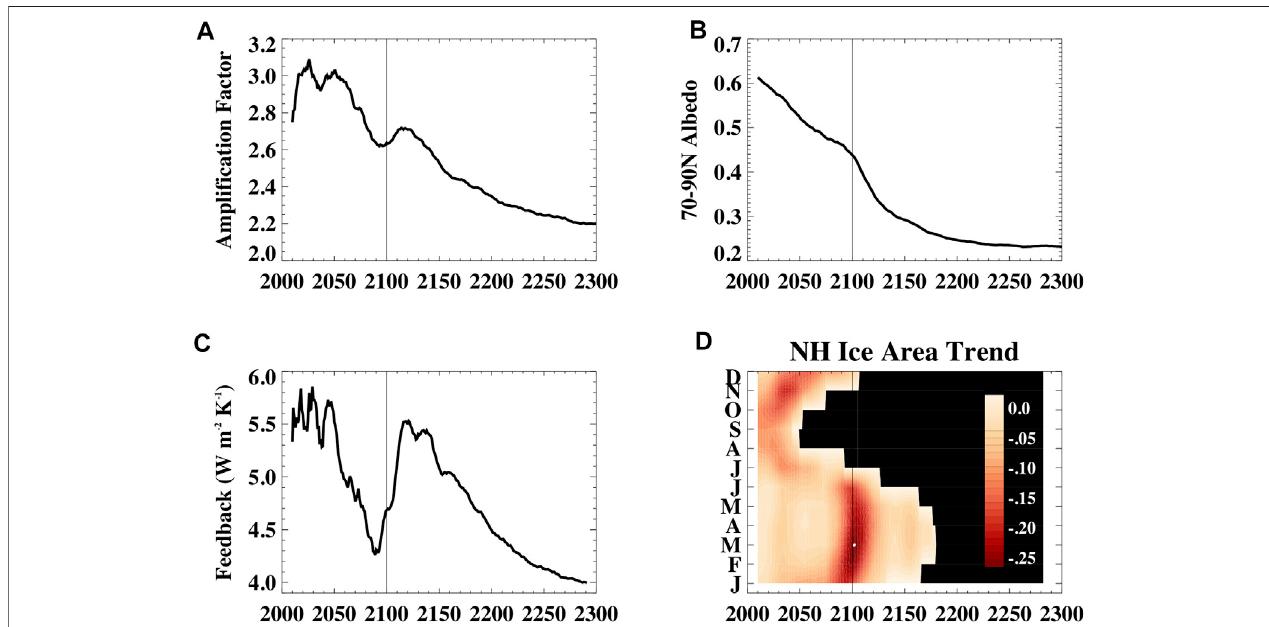
FIGURE 12 | Results from CESM-CAM5 runs that are extended to 2300 using the RCP8.5 scenario including, (A) the annual mean Arctic ampli fi cation factor, (B) the annual mean 70 – 90N effective albedo, (C) the 70 – 90N surface albedo feedback, and (D) the running decadal trend in monthly sea ice area. Values in panel (a), (b), and (c) use 10-years running means. The annual mean effective albedo is computed as the annual surface upward solar radiation divided by the annual mean surface downwardradiationandrepresentsthefractionofsolarradiationre fl ectedfromthesurfaceonanannualbasis.Inpanel(d),blackregionsindicatewhentheicearea is lower than one million km 2 and trends are shown in units of million km 2 per